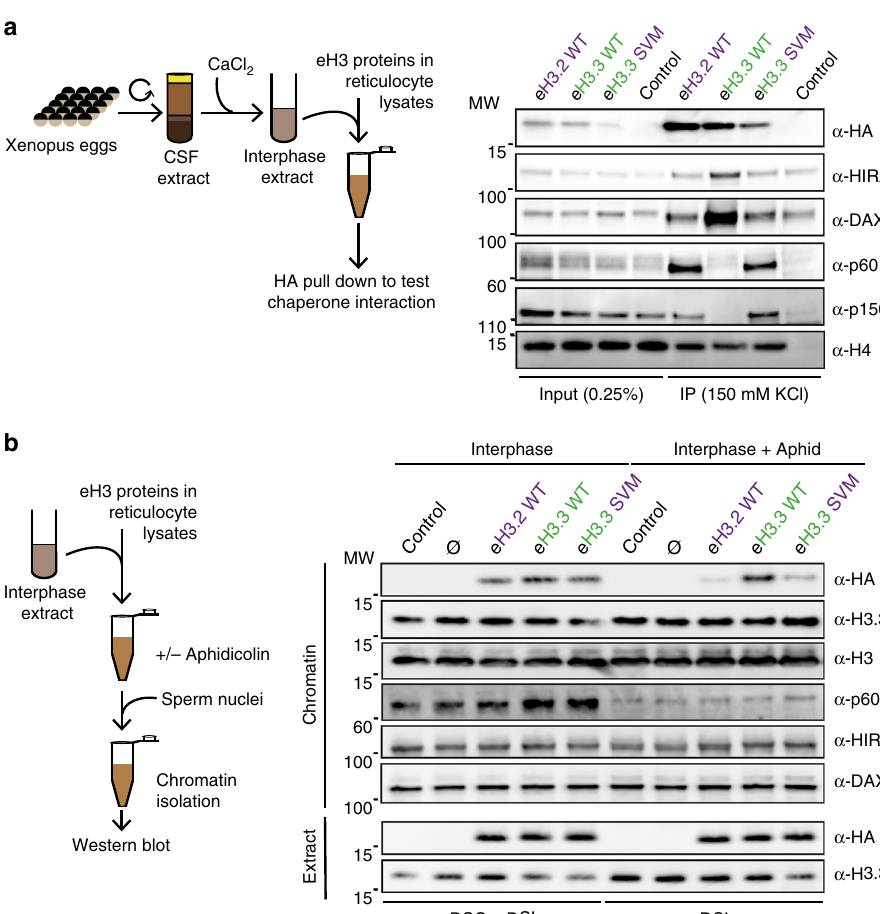
Fig. 3 H3.3 AIG motif permutation changes histone chaperone interactions and histone modes of incorporation into chromatin in X. laevis . a Immunoprecipitation of eH3 AIG triple mutant and controls in interphase extracts. Recombinant proteins are produced in rabbit reticulocyte lysates and pulled down by their HA-tag after incubation. The binding of HIRA, DAXX, p60, and p150 is analyzed by western blotting with speci fi c antibodies. α -HA antibody is used to detect eH3.3. H4 is used as an internal control. Primary antibodies indicated on the right. Molecular weight (MW) markers in kDa indicated on the left. b Incorporation of eH3 AIG triple mutant and controls into sperm chromatin in interphase extracts. Puri fi ed nuclei remodeled in the interphase extracts supplemented with indicated eH3.3 in the presence or absence of aphidicolin are analyzed by western blotting with indicated antibodies. α -HA antibody is used to detect eH3.3. Primary antibodies indicated on the right. Molecular weight (MW) markers in kDa indicated on the left. DSC: DNA-synthesis coupled, DSI: DNA-synthesis independent mode of incorporation. Source data are provided as a Source Data fi